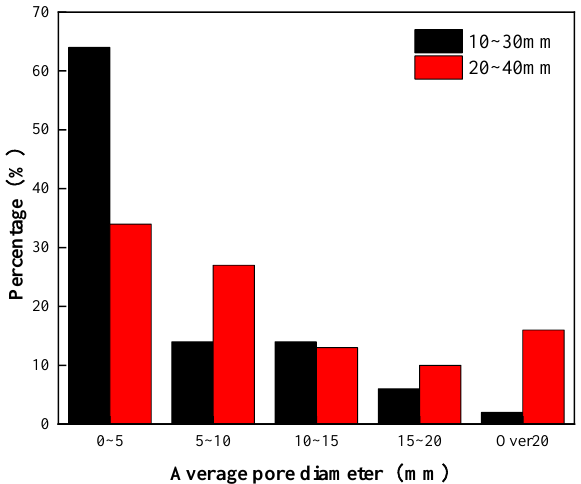
Figure 7. Average diameter distribution of pore spaces in planting concrete. The average diameter of planting concrete versus planar pore area is shown in Figure 8. As shown in Figure 8, the average diameter of the planting concrete shows an exponential relationship with the porosity of the planes. The R 2 of the exponential relationship equation bx y Ae = is 0.98. It shows a strong relationship between the average diameter of the pores and the area of the planar pores.